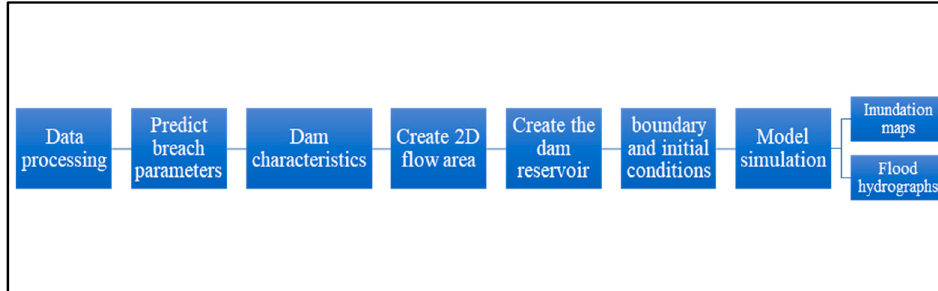
Figure 2. Flow chart of the dam break stages.